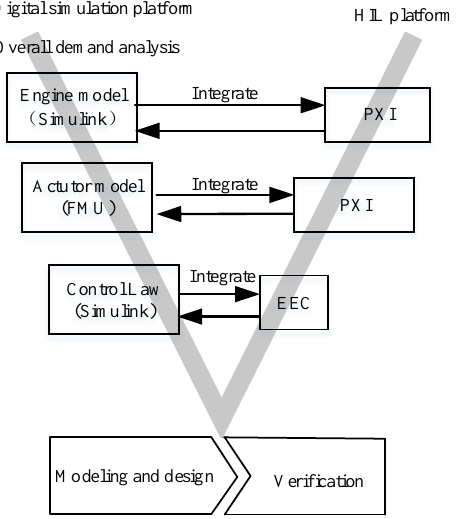
Figure 24. Model and control logic design, analysis, integration and testing process.